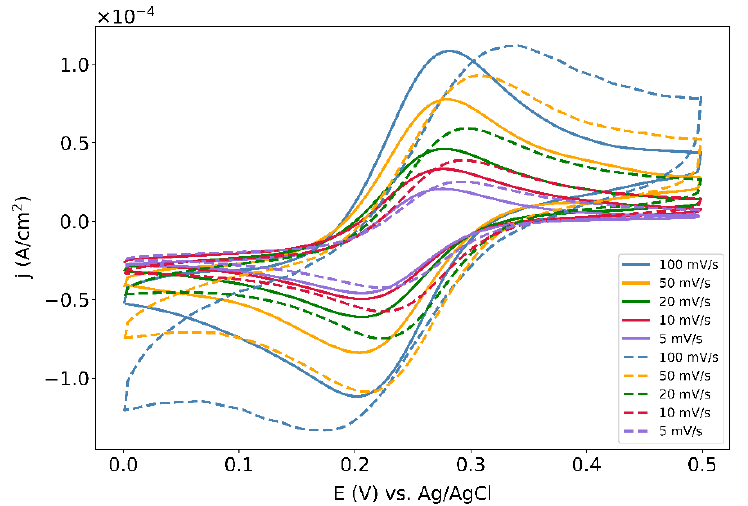
Figure 4. Cyclic voltammograms of Au stripes on chip electrode (solid curves), at different scan rates (legend), compared to measurements obtained using a commercial Au electrode (dashed curves) in 1 mM ferricyanide solution.